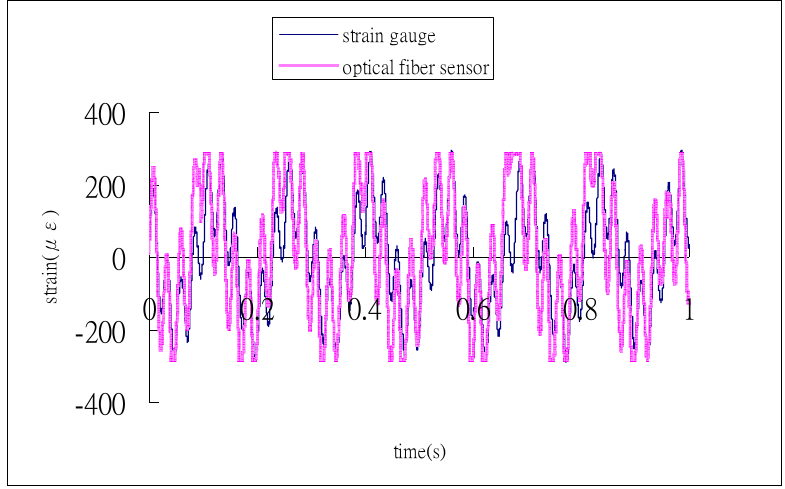
Figure 12. Dynamic strain of a cantilever beam subjected to dual excitation frequencies of 7 Hz and 40